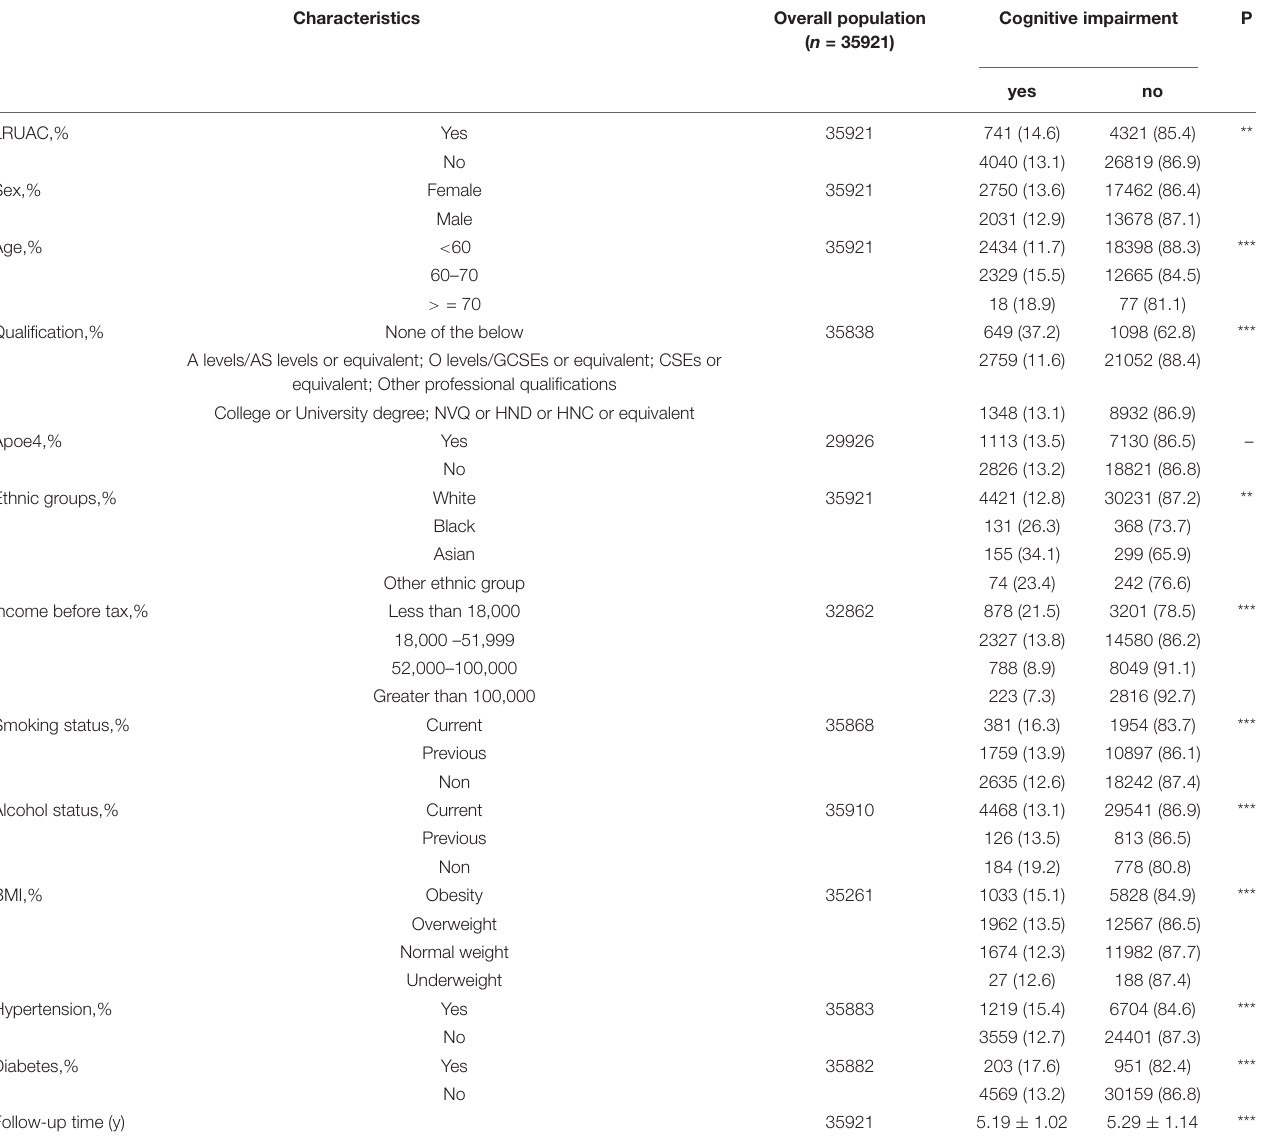
TABLE 1 | Demographic and clinical characteristics of patients at baseline. Characteristics Overall population